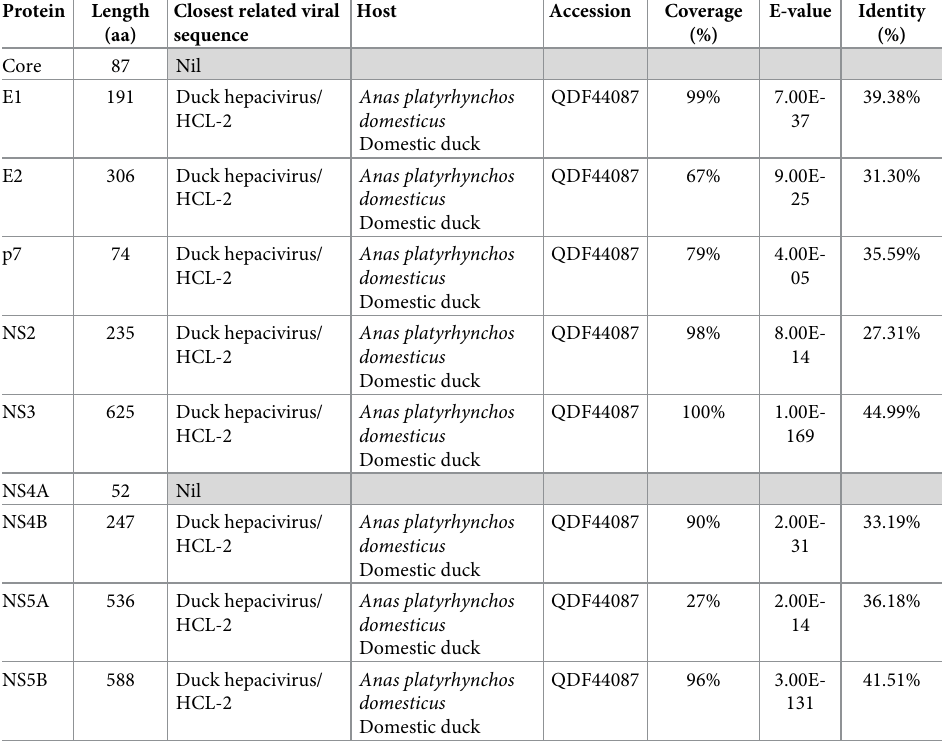
Table 3. Jogalong virus protein sequence